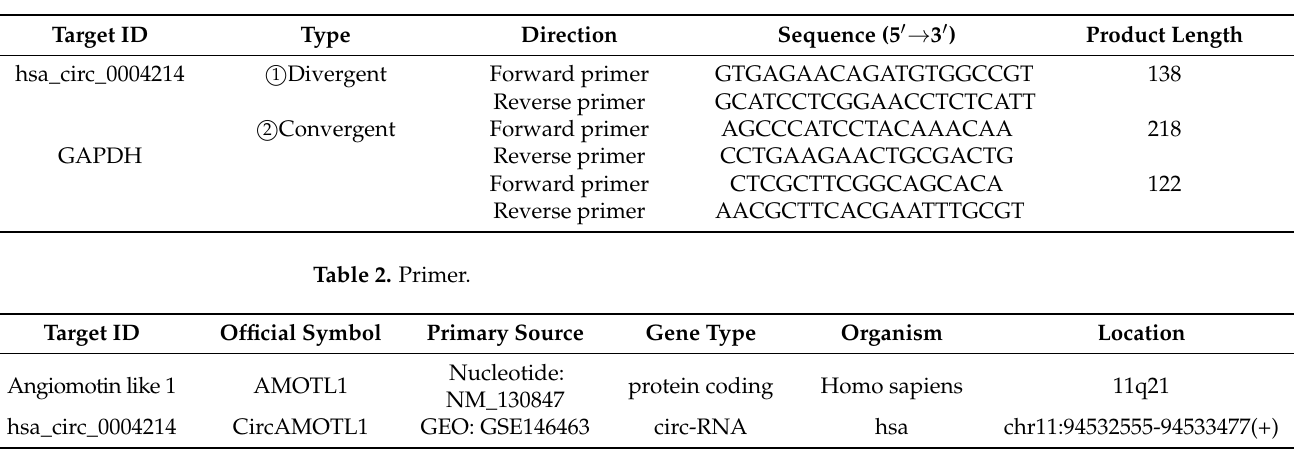
Table 1. Target information.